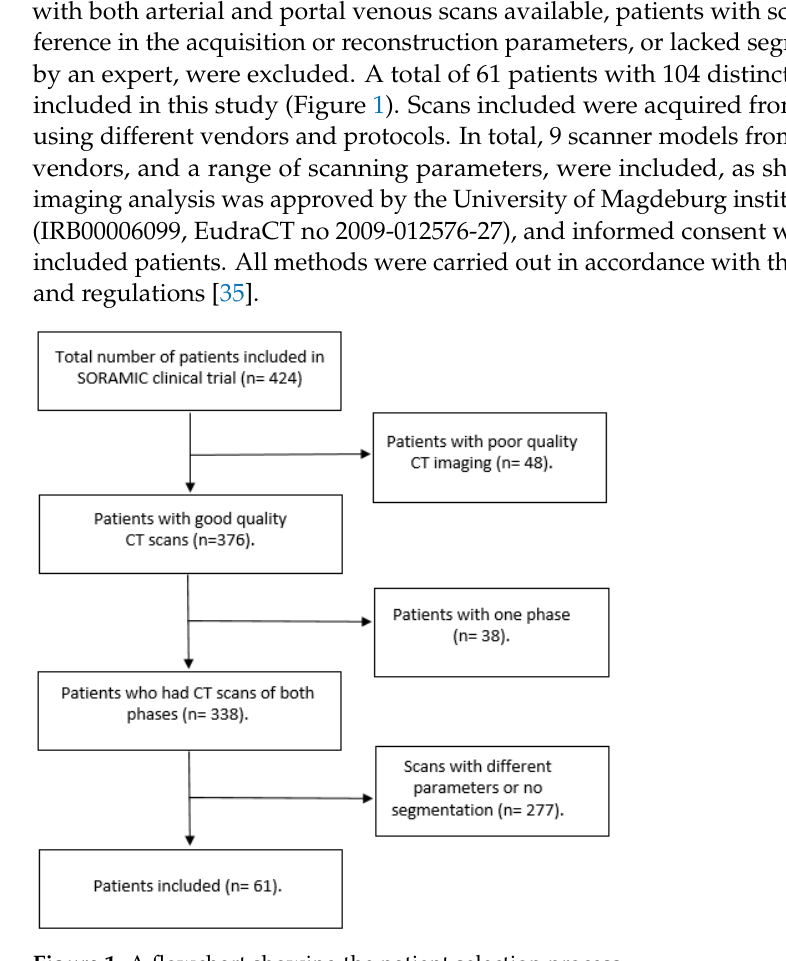
Figure 1. A flowchart showing the patient selection process. Table 1. Acquisition and reconstruction parameters for the imaging dataset.